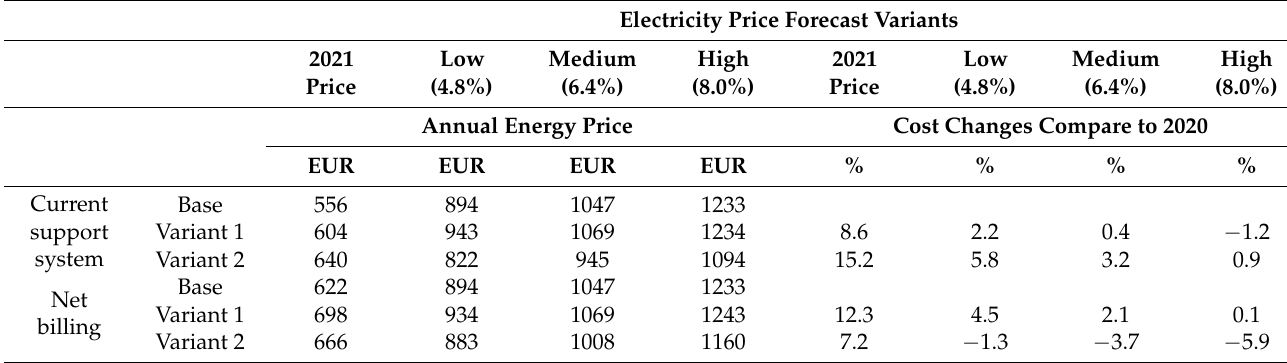
Table 7. Impact of different options of accumulation on the annual energy